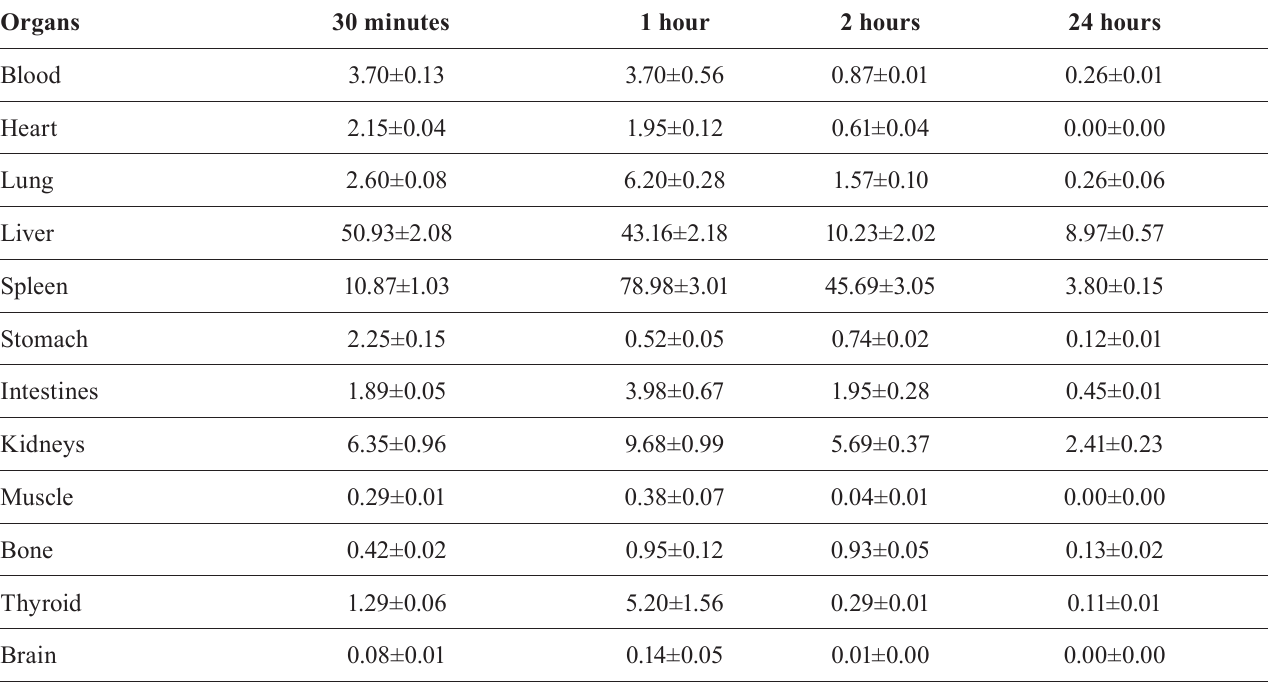
TABLE II - Biodistribution of 99m Tc-HMPAO-labeled platelets in BALB/c mice (data are presented as the percentage of injected dose per organ weight,